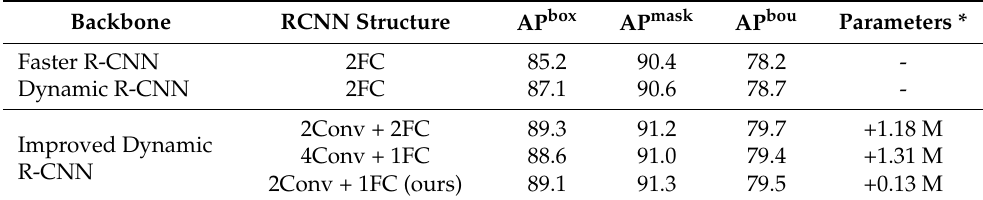
Table 5. Comparison with different detector structures on the test set.